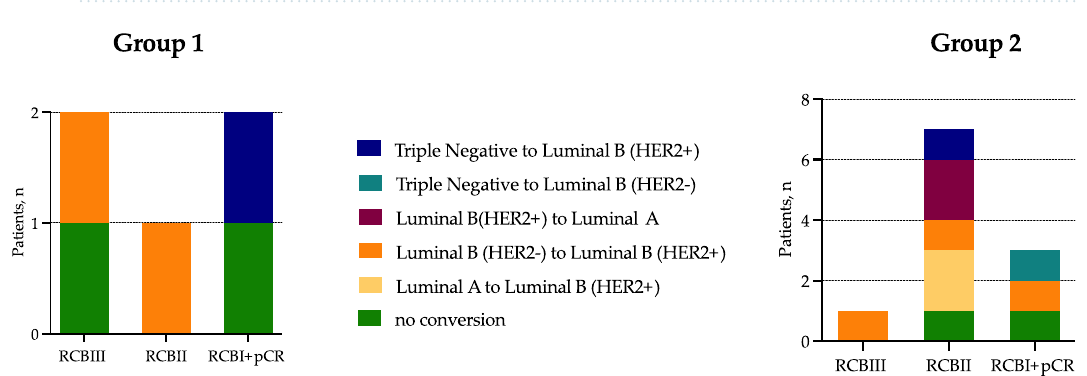
Figure 5. Variants of molecular subtype conversion in CTCs in untreated (I) breast cancer patients and treated by NAC (II).